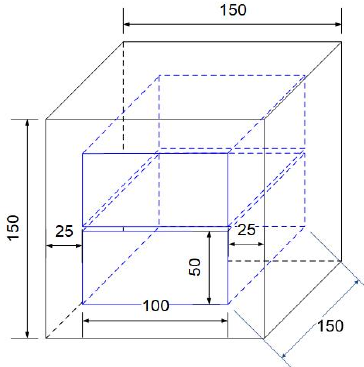
Figure 5. Preparation outline of the concrete speci- men for acid storage.